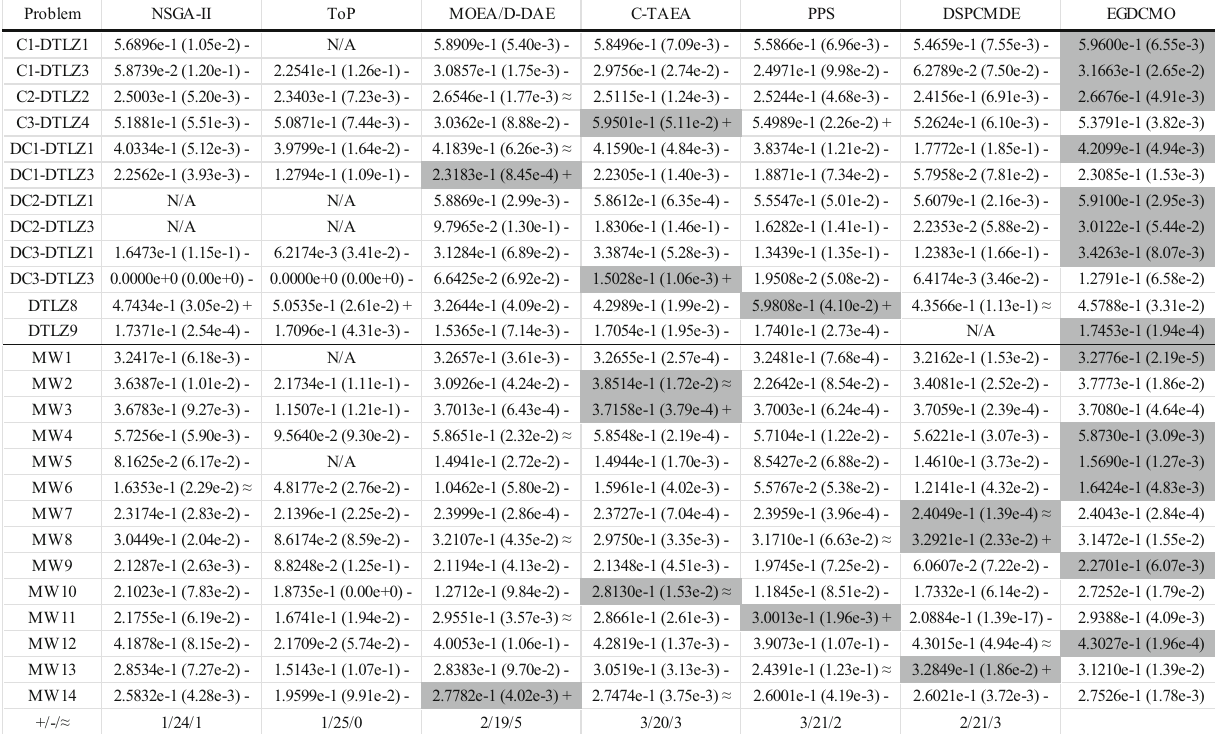
Table 6 Statistics of the HV metric obtained by the proposed EGDCMO and all the compared CMOEAs on the DTLZ and MW problems Problem NSGA-II ToP MOEA/D-DAE C-TAEA PPS DSPCMDE